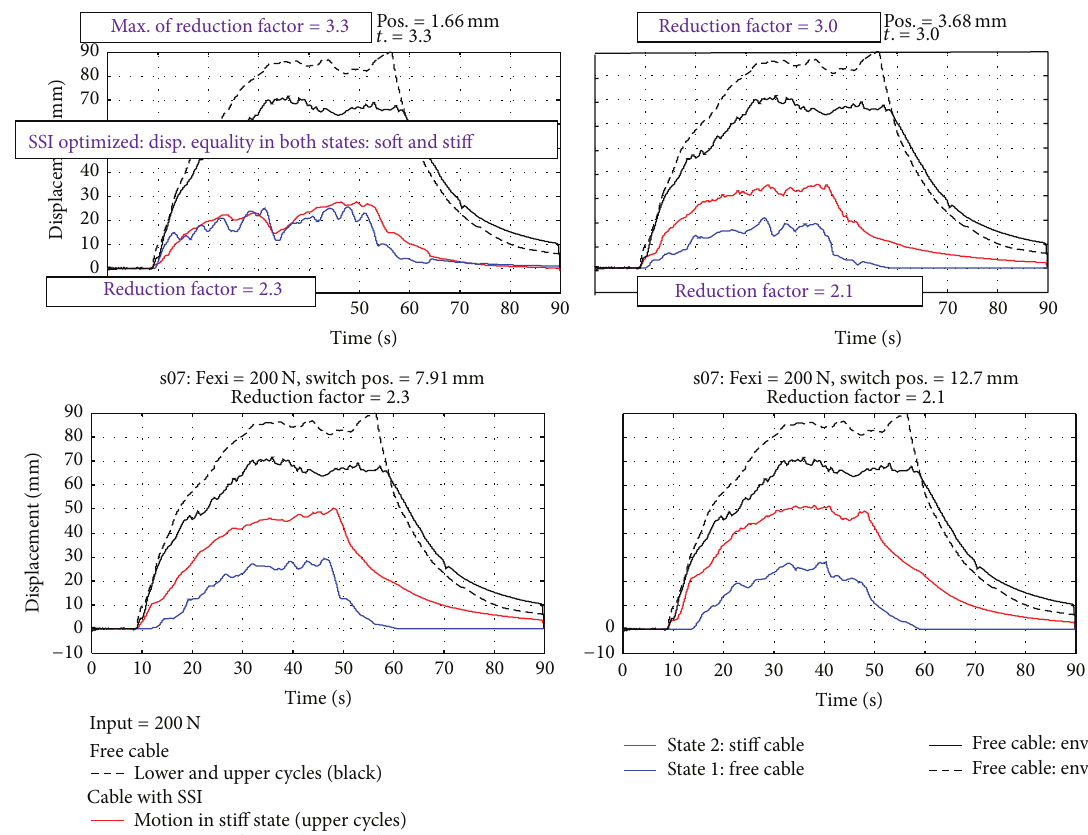
Figure 13: Variation of the reduction factor with respect to the switch position (4 different tensions of the